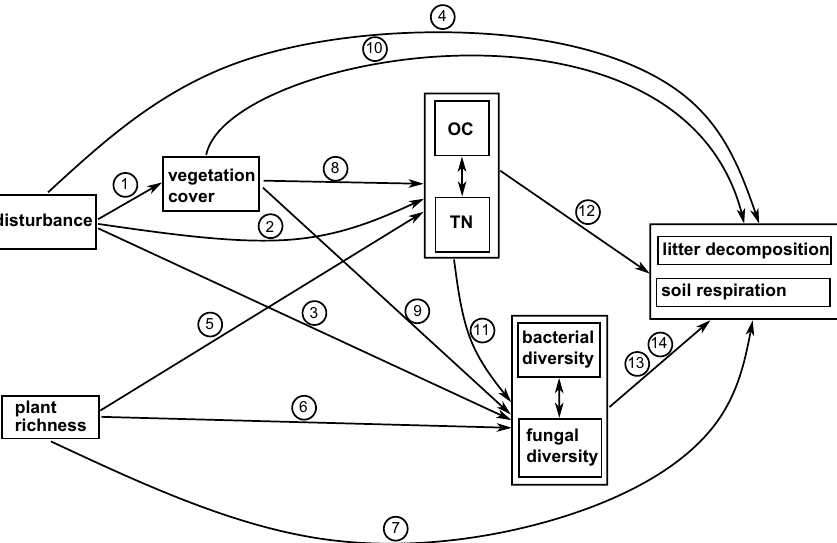
Figure 5. Meta model depicting hypothetical causal relations between variables soil disturbance, plant species richness, vegetation cover, soil organic carbon (OC) and soil total nitrogen (TN), soil microbial diversity (Shannon diversity), and soil functions (soil respiration and litter decomposition). Arrows show direction of causal relation. Double headed arrows indicate relationships modelled as bi-directional effects (correlations). For references and sign of the hypothetical effect, see Supplementary Table S2.